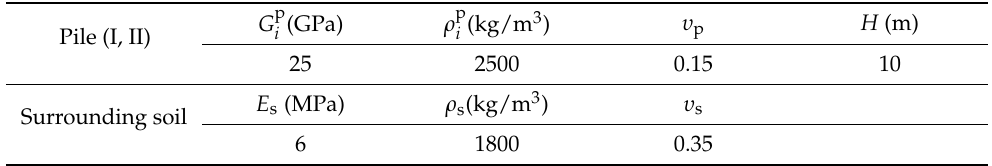
Figure 3. Comparison of the present solution and Abaqus solution at different testing points along the radius of the large-diameter pile top: ( a ) r = r h ; ( b ) r = 0.2 R ; ( c ) r = 0.5 R ; ( d ) r = 0.7 R ; ( e ) r = 1.0 R . Table 2. The parameters of the pile-soil system of Zheng et al.